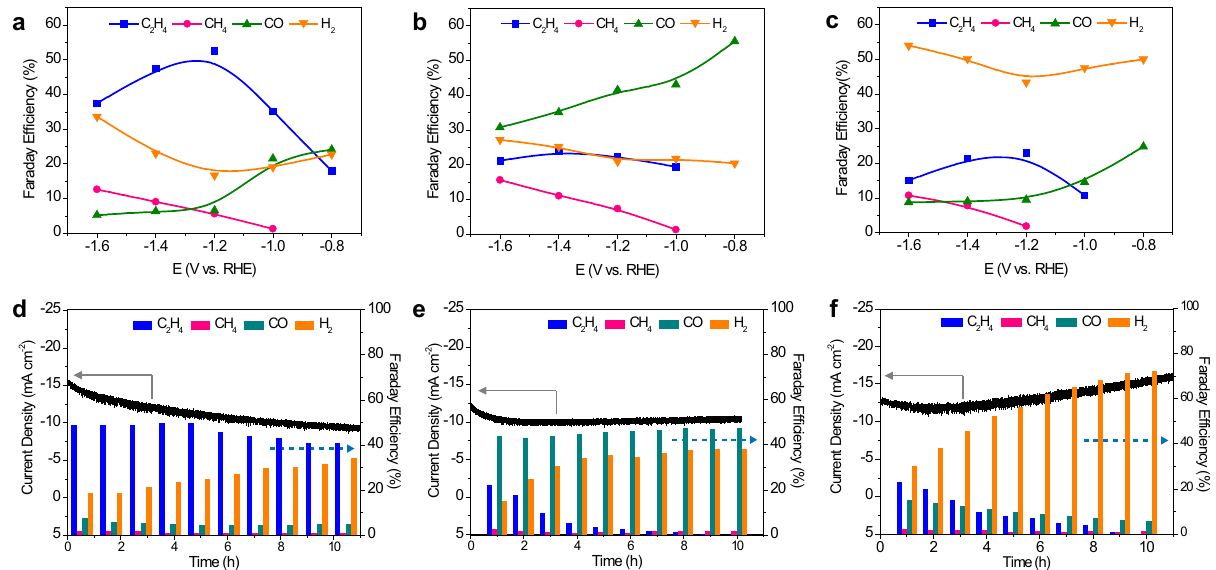
Fig. 3 CO 2 RR performances of the catalysts. a – c FEs of various reduction products for AuNN@PCN-222(Cu), AuNP@PCN-222(Cu), and PCN-222(Cu), respectively, at different potentials. d – f Chronoamperometric stability tests for AuNN@PCN-222(Cu), AuNP@PCN-222(Cu), and PCN-222(Cu) at − 1.2, − 1.0, and − 1.2 V, respectively, with the gaseous products measured every 1 h.